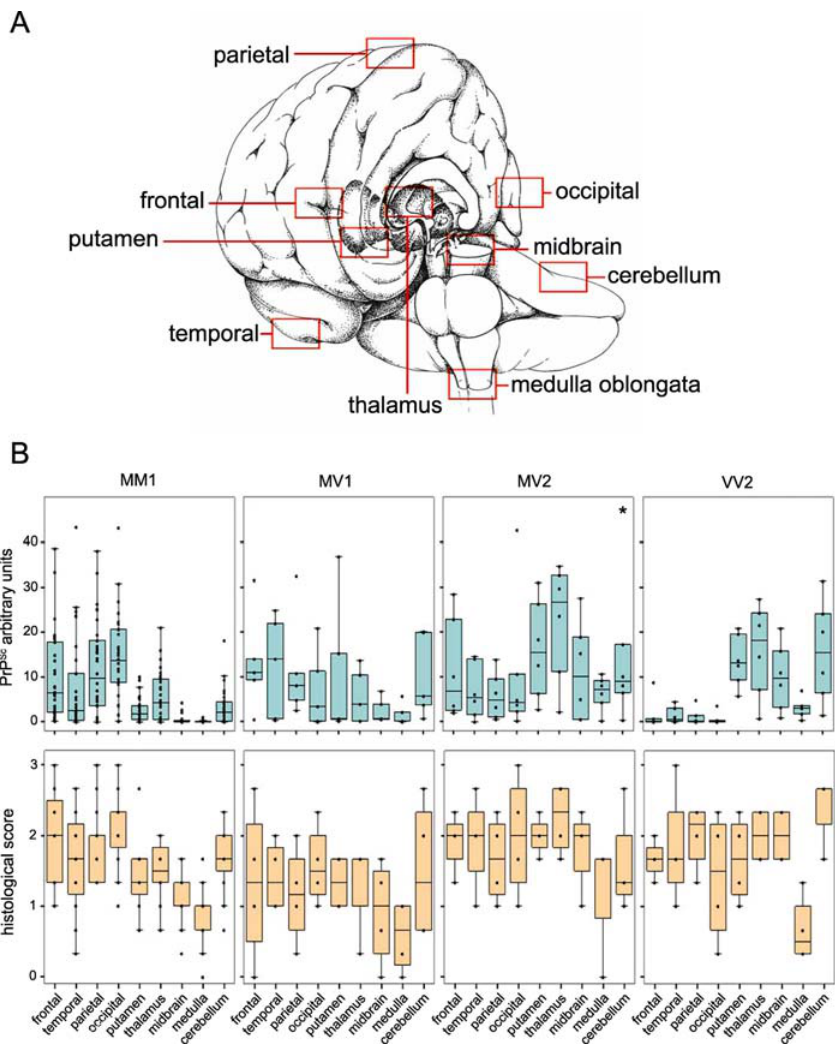
Figure 1. Comparison of PrP Sc Profiles to Lesion Profiles (A) Schematic drawing indicating sampled areas which are used for the generation of PrP Sc profiles (red boxes). (B) Biochemical PrP Sc profiles are indicated in the upper panel, whereas histological lesion profiles are shown in the lower panel. Patients were grouped according to [12] in MM1, MV1, MV2, and VV2. Brain regions are shown on the x -axis. Values for PrP Sc amounts are given in arbitrary units measured in relation to the PrP Sc standard. Values for lesion profiles were obtained by averaging the scores for spongiosis (scored on a scale from 0–4), astrogliosis, and PrP immunoreactivity (both scored on a scale from 0–3). Black dots represent individual patients and black lines within boxes represent medians; boxes encompass 25th and 75th percentiles of distribution. One outlier (denoted by asterisk: MV2, cerebellum, PrP Sc content ¼ 84.1) has been omitted in the graphical representation. DOI: